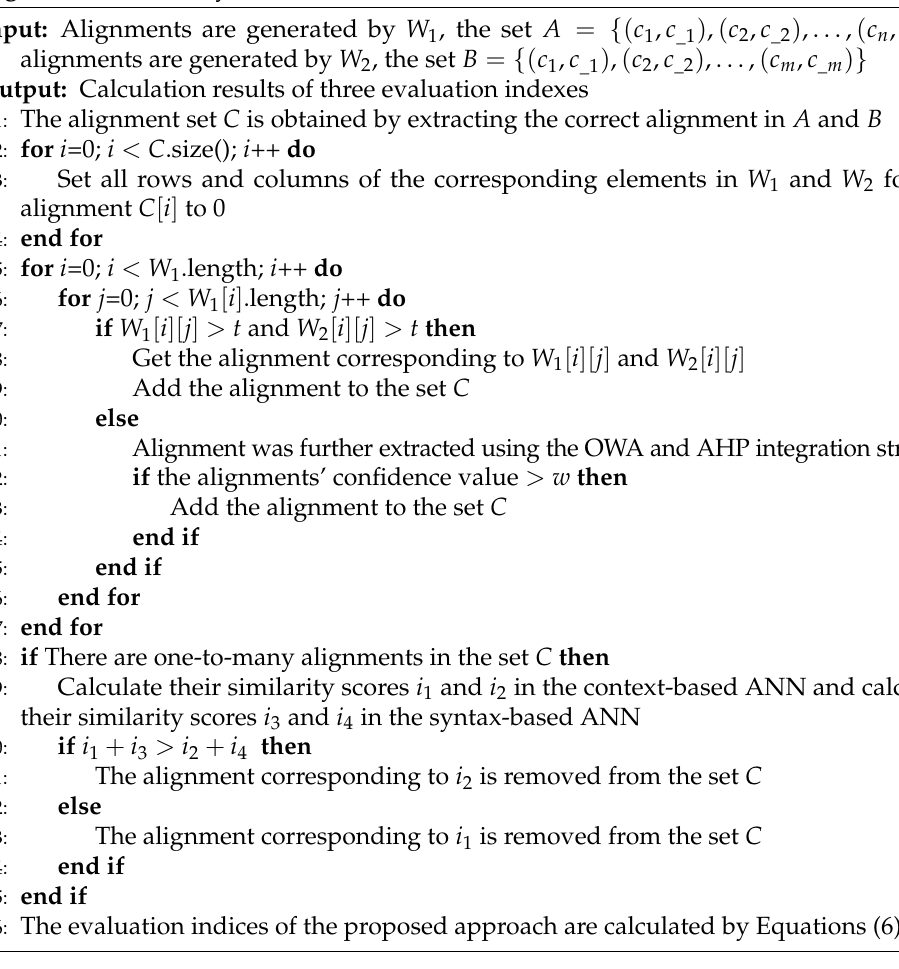
Algorithm 2 Similarity Feature Matrix